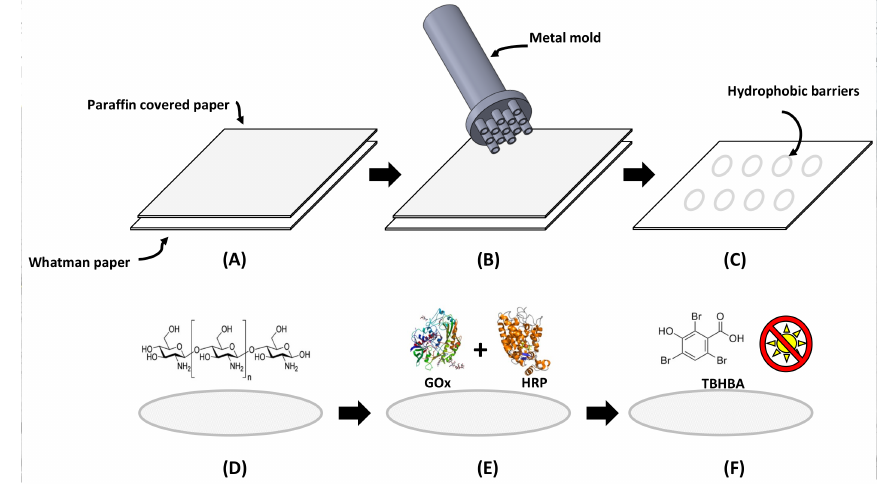
Figure 1. Schematic representation of the paper-based sensor fabrication. From ( A ) to ( C ) the development of the detection zone is shown. ( A ) Paraffin covered paper was attached to Whatman paper, ( B ) a heated metal mold was pressed against papers, and ( C ) defined micro zones with hydrophobic barriers were obtained. Then from ( D ) to ( F ) chemical modification of detection zone is presented: ( D ) chitosan modification, ( E ) the addition of an enzymatic mixture, and ( F ) the addition of TBHBA under dark